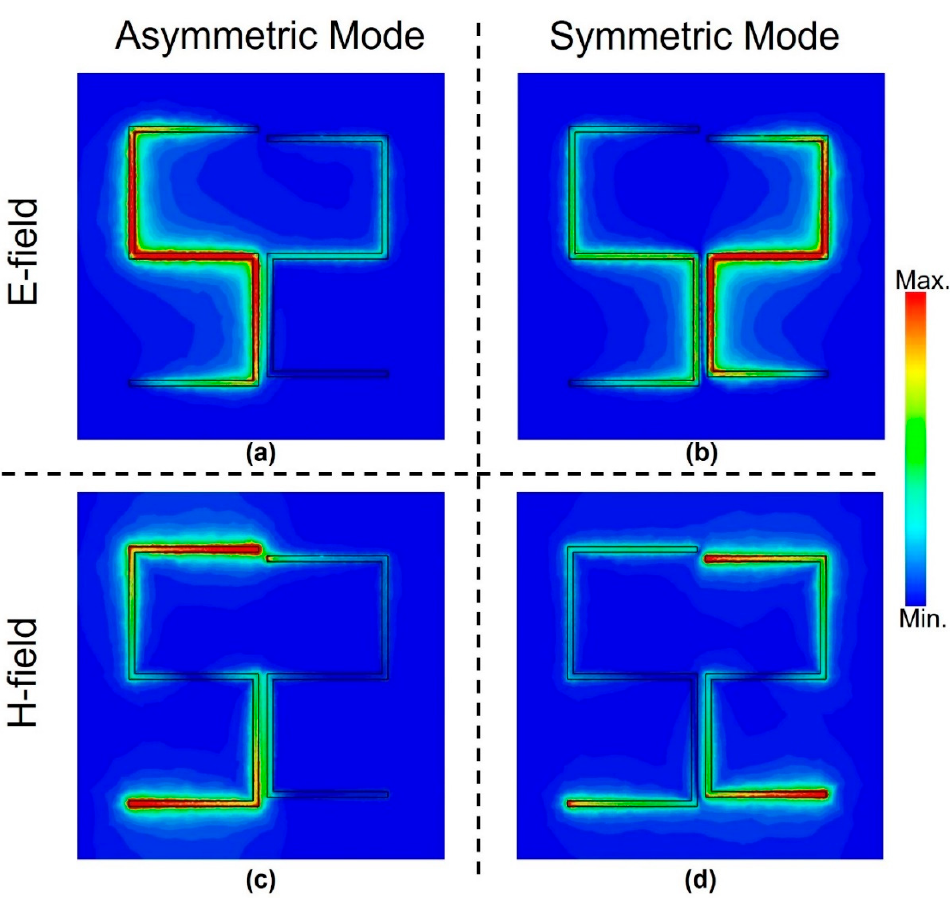
Figure 4. Spatial distributions of electric fields ( a ) and ( b ) , magnetic fields ( c ) and ( d ) at the surface of the metasurface for the asymmetric resonance ( a ) and ( c ), and symmetric dipole resonance ( b ) and ( d ) modes.